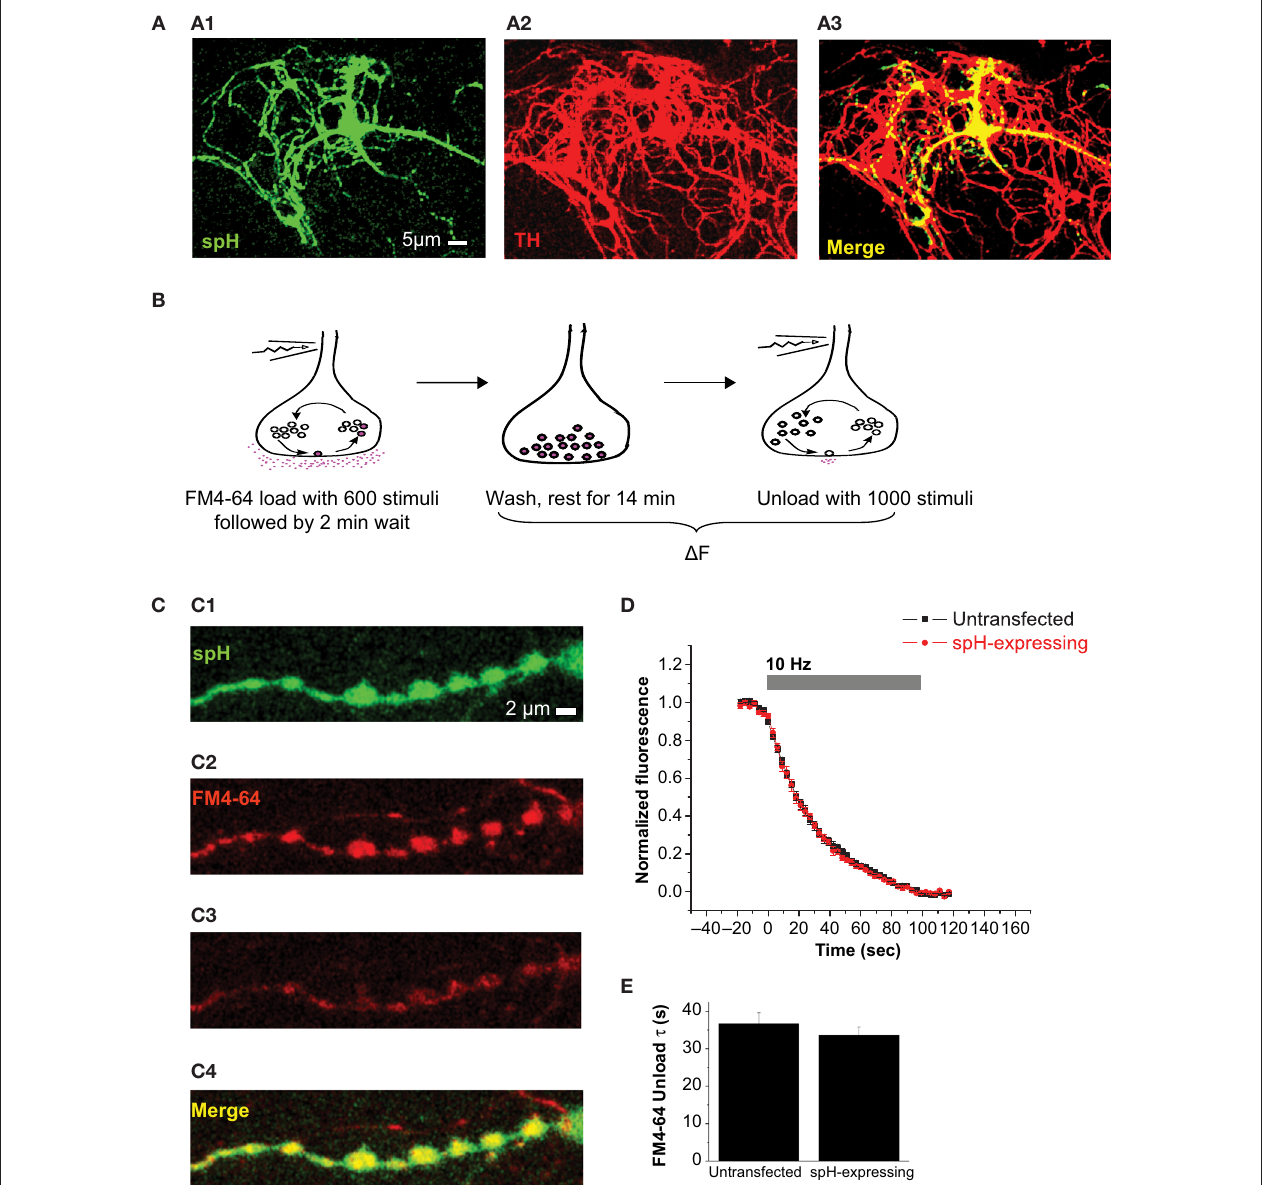
FIGURE 1 | SynaptopHluorin is expressed at presynaptic terminals of dopaminergic neurons without perturbation of native vesicle exocytosis. (A) SynaptopHluorin (spH), a fusion protein consisting of VAMP-2 tagged with pHluorin (GFP modifi ed for greater pH sensitivity, Miesenböck et al., 1998), was transfected into primary cultures of DA neurons dissected from the ventral midbrain of neonatal rats. spH is expressed in both the soma and neurites. Shown here is spH (A1) in a DA neuron identifi ed by immunostaining for DA-specifi c marker tyrosine hydroxylase (A2) . Merge (A3) . Scale bar, 5 µm. (B) Protocol for FM dye loading and unloading. Neurons were stimulated at 10 Hz for 60 s in the presence of FM4-64 dye. The dye remained in the bath for 2 min after the end of the stimulus to allow complete endocytosis, and was then rapidly removed by a 4-min wash with 1 mM Advasep-7, a dye chelator.